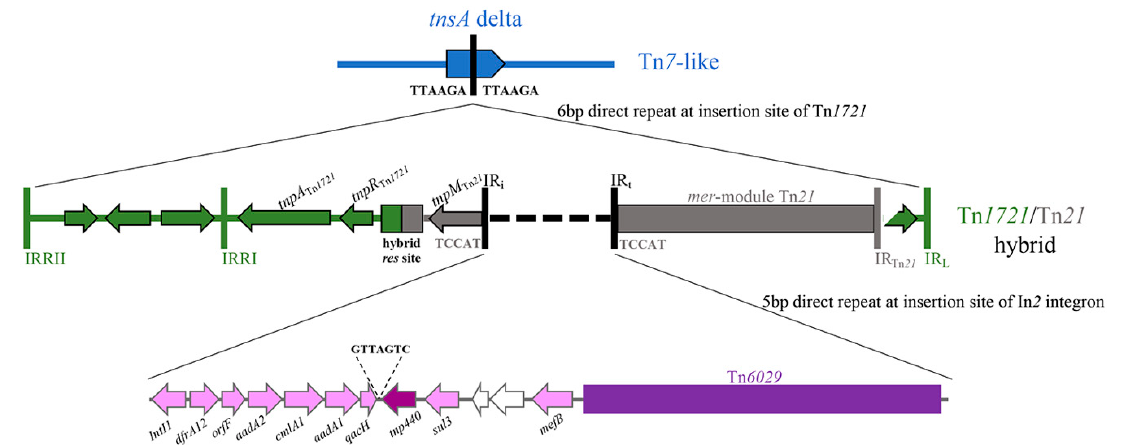
Figure 2. Diagrammatic representation of the resistance genes, class 1 integron, transposons and insertion elements that form the complex resistance locus on the plasmid.